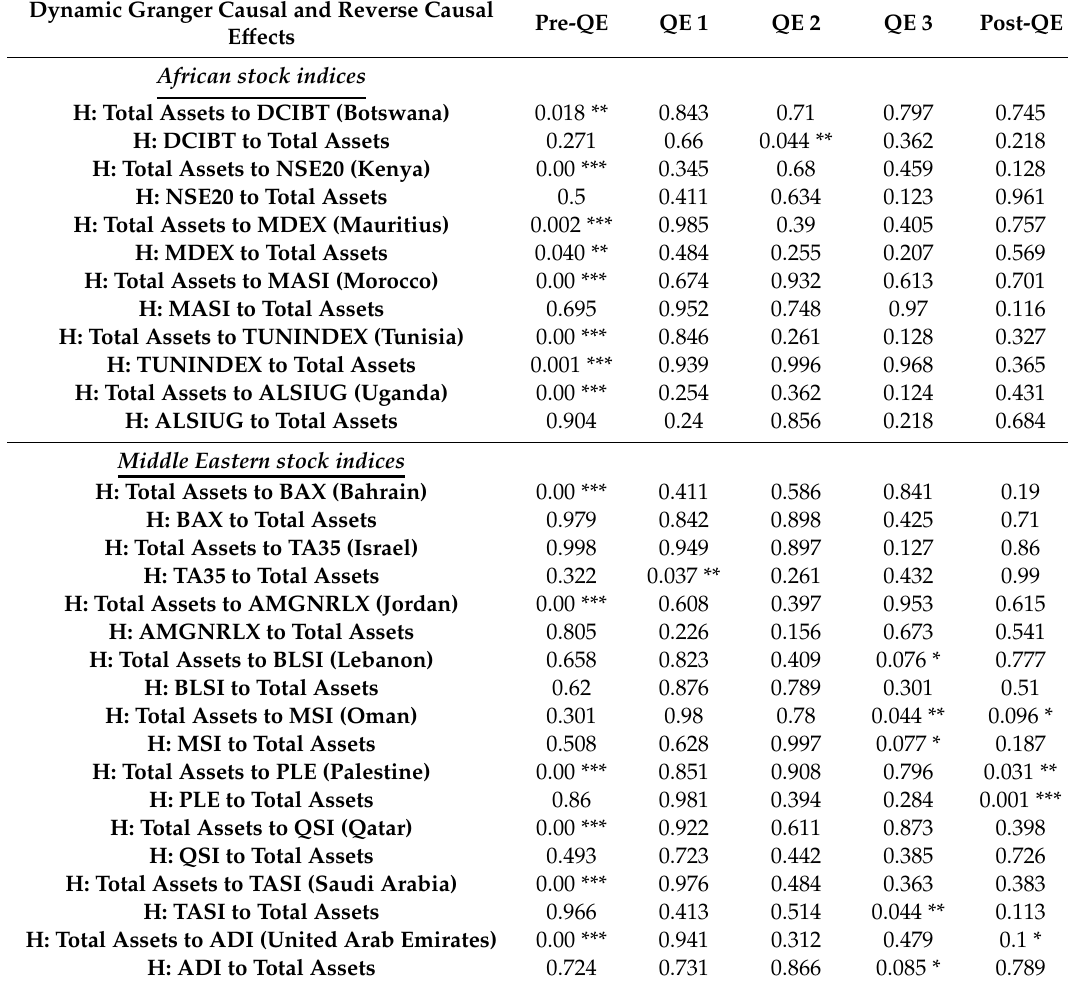
Table 7. Results of the dynamic Granger causality